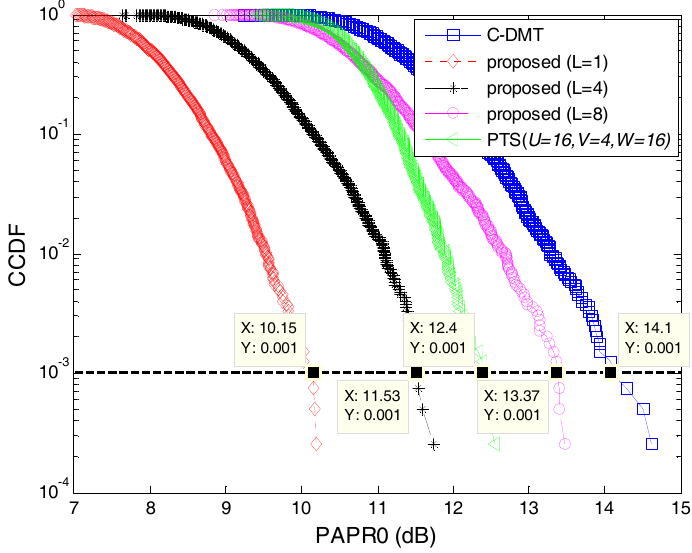
Figure 6. Complementary cumulative distribution function (CCDF) performance comparison.